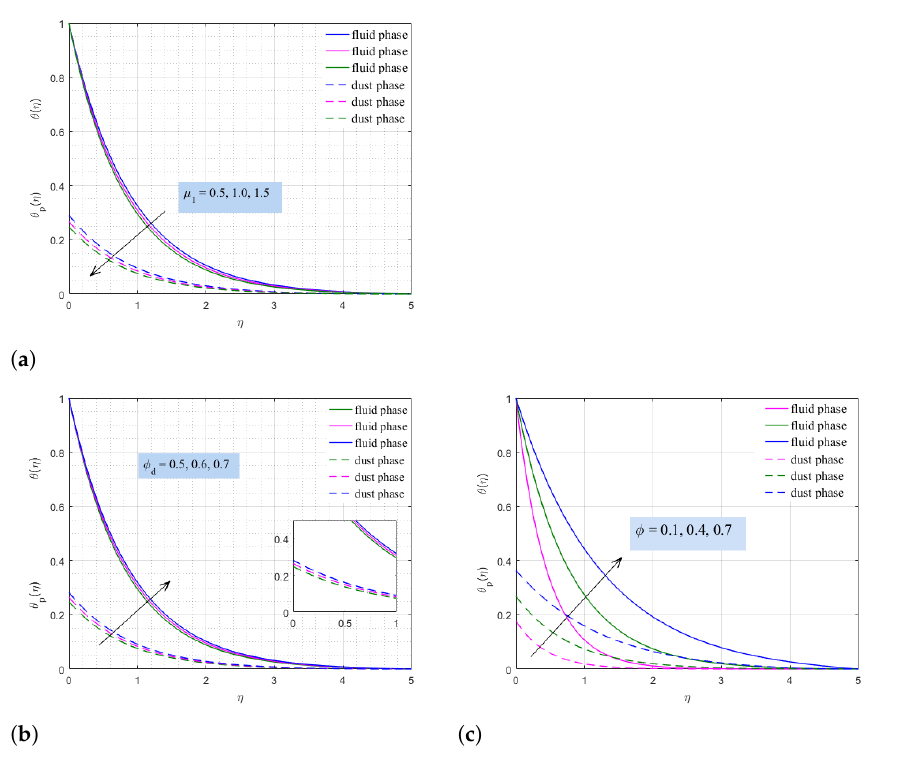
Figure 5. Concentration profiles for different values of parameters. ( a ) Change in temperature distribution at different µ 1 values. ( b ) Change in temperature distribution at different φ d values. ( c ) Change in temperature distribution at different φ